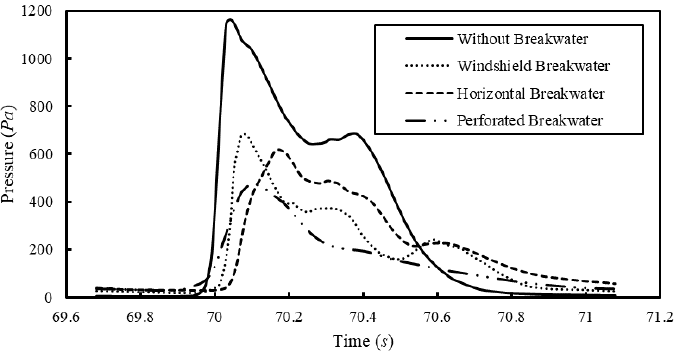
Figure 15. Impact of breakwaters on dynamic greenwater pressure variation at “PP2” on the vertical deck plate ( Aw = 0.1125 m, λ = 3.75 m).